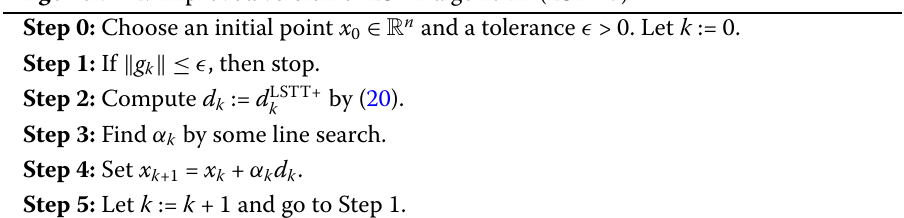
Algorithm 2: Improved version of LSTT algorithm